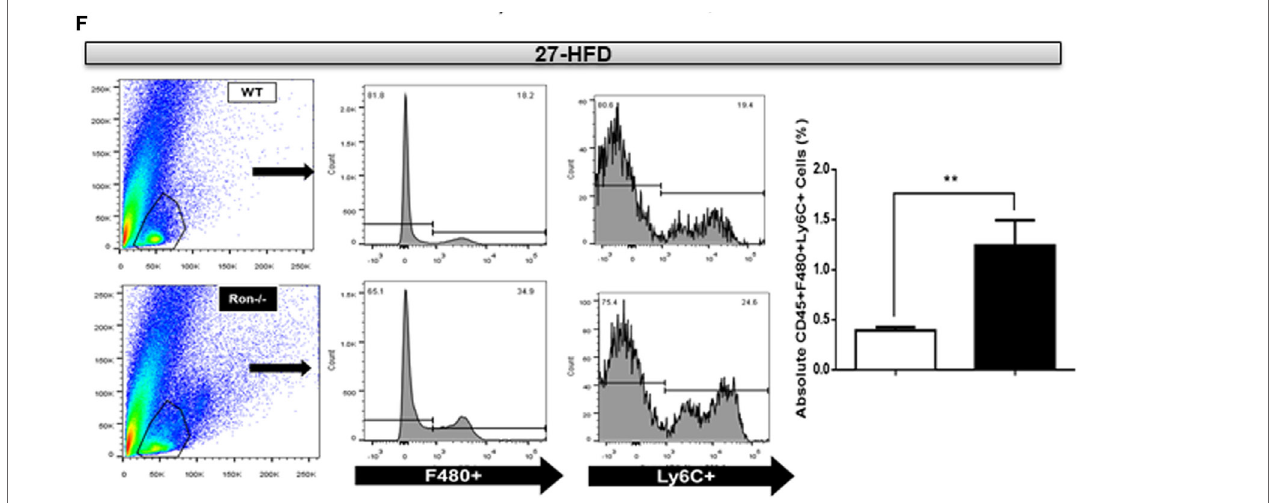
FigUre 5 | Loss of Ron stimulates exacerbated neuroinflammation following diet-induced obesity. (a) Weight of wild-type (WT) and Ron − / − mice maintained on a HFD for 18 ( n = 16 mice/genotype) and/or 27 weeks ( n = 16 mice/genotype). (B–D) WT and Ron − / − mice were maintained on a HFD for 18 or 27 weeks and expression of M1 genes, M2-gene Arg-1, Ly6C, and matrix metalloproteinases (MMPs) in the central nervous system (CNS) was assessed by qPCR ( n = 6 mice/ genotype). (e,F) Total CNS immune cells were isolated from the CNS of WT and Ron − / − mice maintained on a HFD for 18 or 27 weeks and numbers of CD45 + F480 + Ly6C + infiltrating macrophages was assessed by flow cytometry ( n = 8 mice/genotype) (* P < 0.05, ** P < 0.01, *** P <